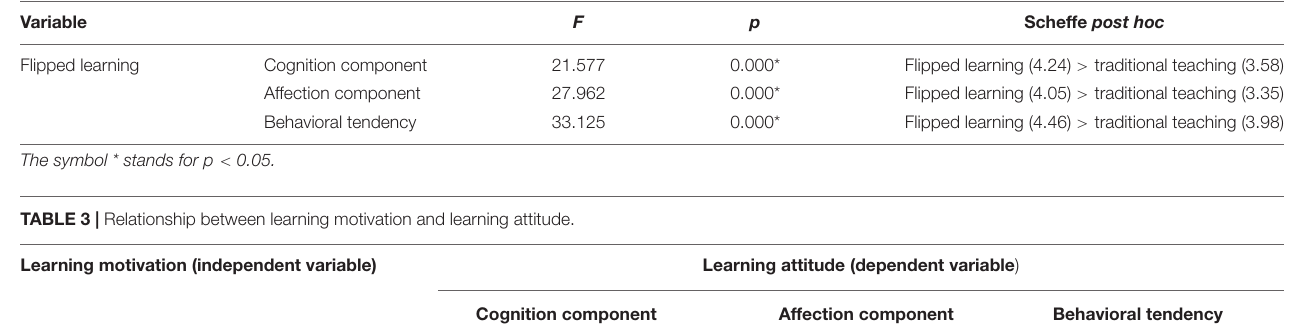
TABLE 2 | Differential analysis of flipped learning in learning attitude.